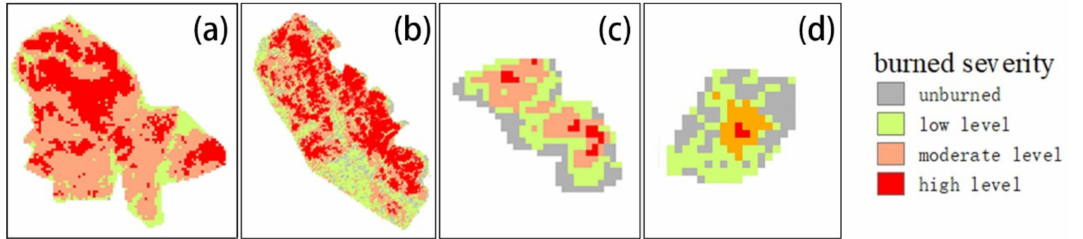
Figure 3. Distribution of burn severity in the study area. ( a – d ) indicate Zone 1, Zone 2, Zone 3, and Zone 4 study areas,